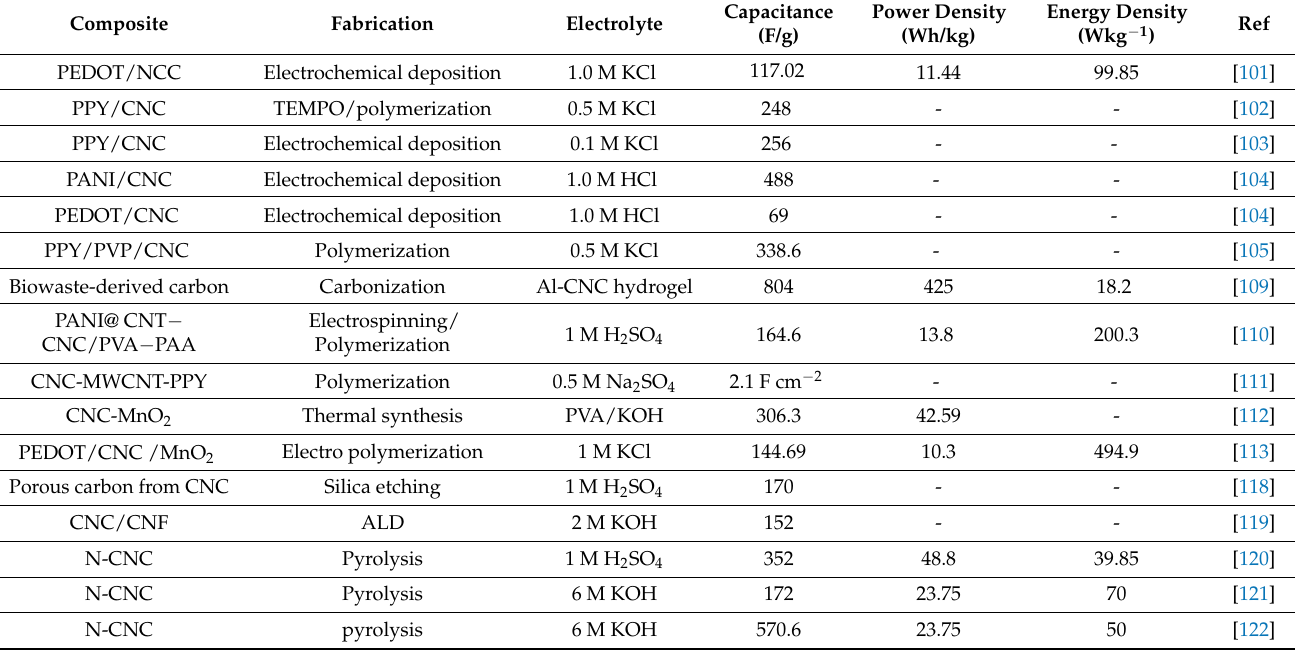
Table 2. Comparison of CNC-based supercapacitor